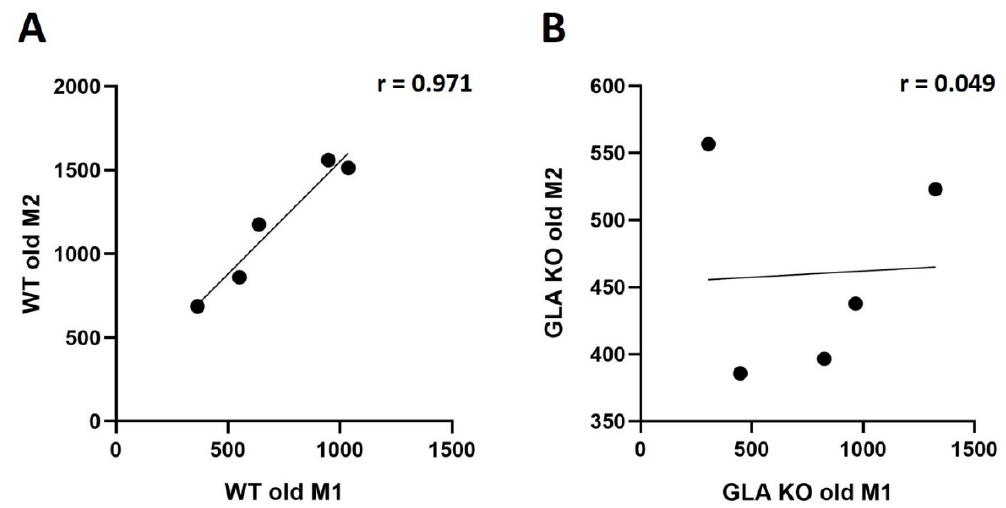
Figure 4. M1/M2 ratio analysis in DRG of old WT and GLA KO mice. ( A ) Pearson’s correlation analysis of M1 and M2 distribution in DRG of old WT mice (r = 0.971, p < 0.01). ( B ) Pearson’s correlation analysis of M1 and M2 distribution in DRG of old GLA KO mice (r = 0.049, p > 0.05). Abbreviations: DRG = dorsal root ganglia; GLA KO = alpha-galactosidase A knockout; r = Pearson’s correlation coefficient; WT = wildtype.